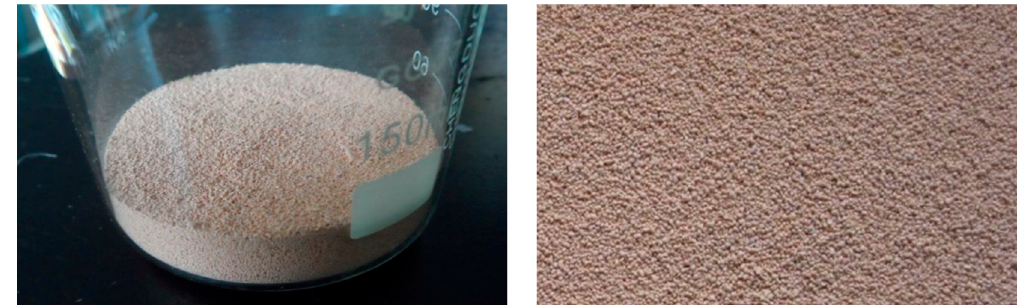
Figure 10. 6201-Type Supports.